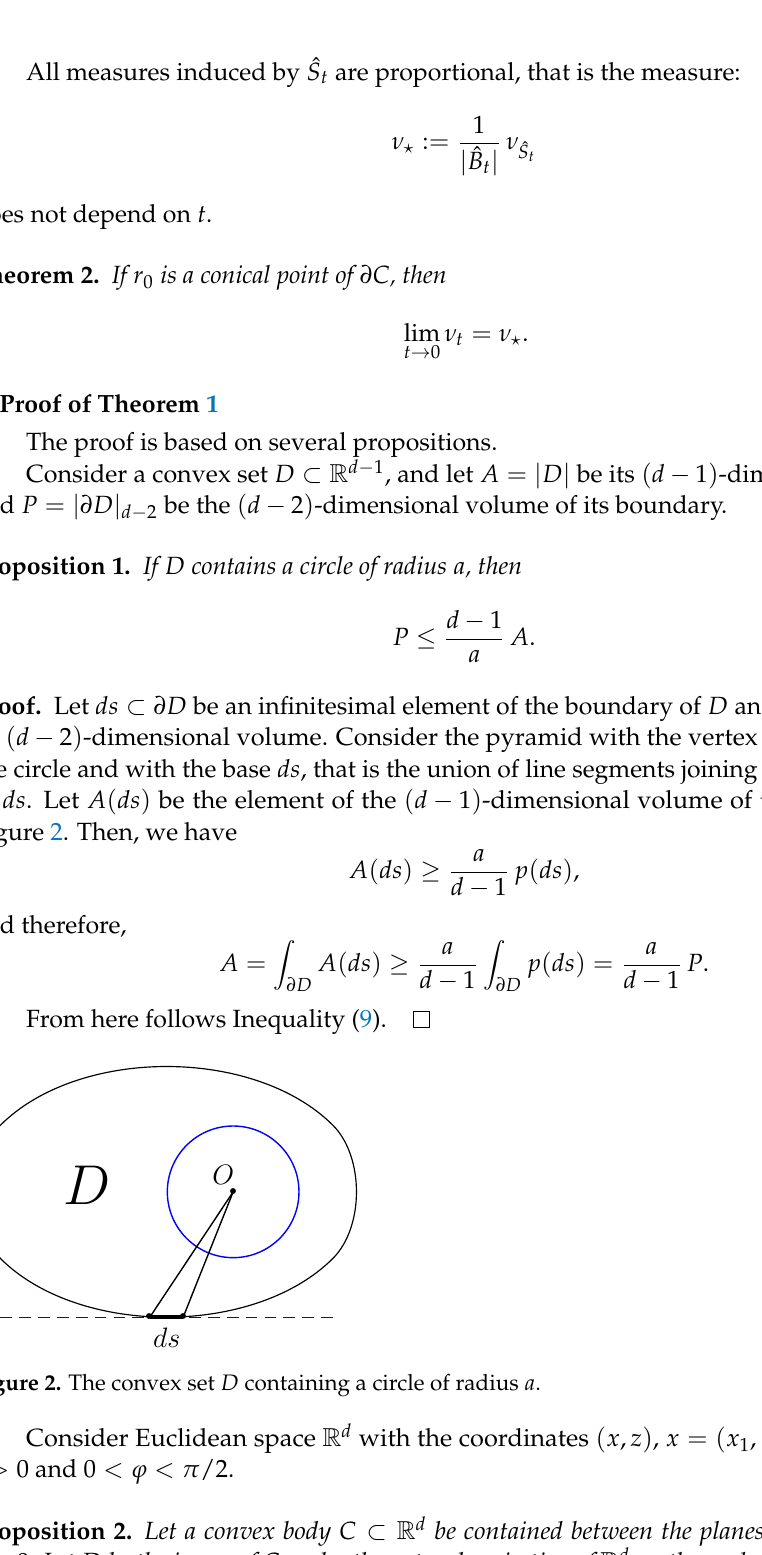
t cot ϕϕϕ ϕ ϕ Figure 3: The body C between two parallel planes z = 0 and z = t is shown. Here U is represented by the union of two curves bounded by the points. 7